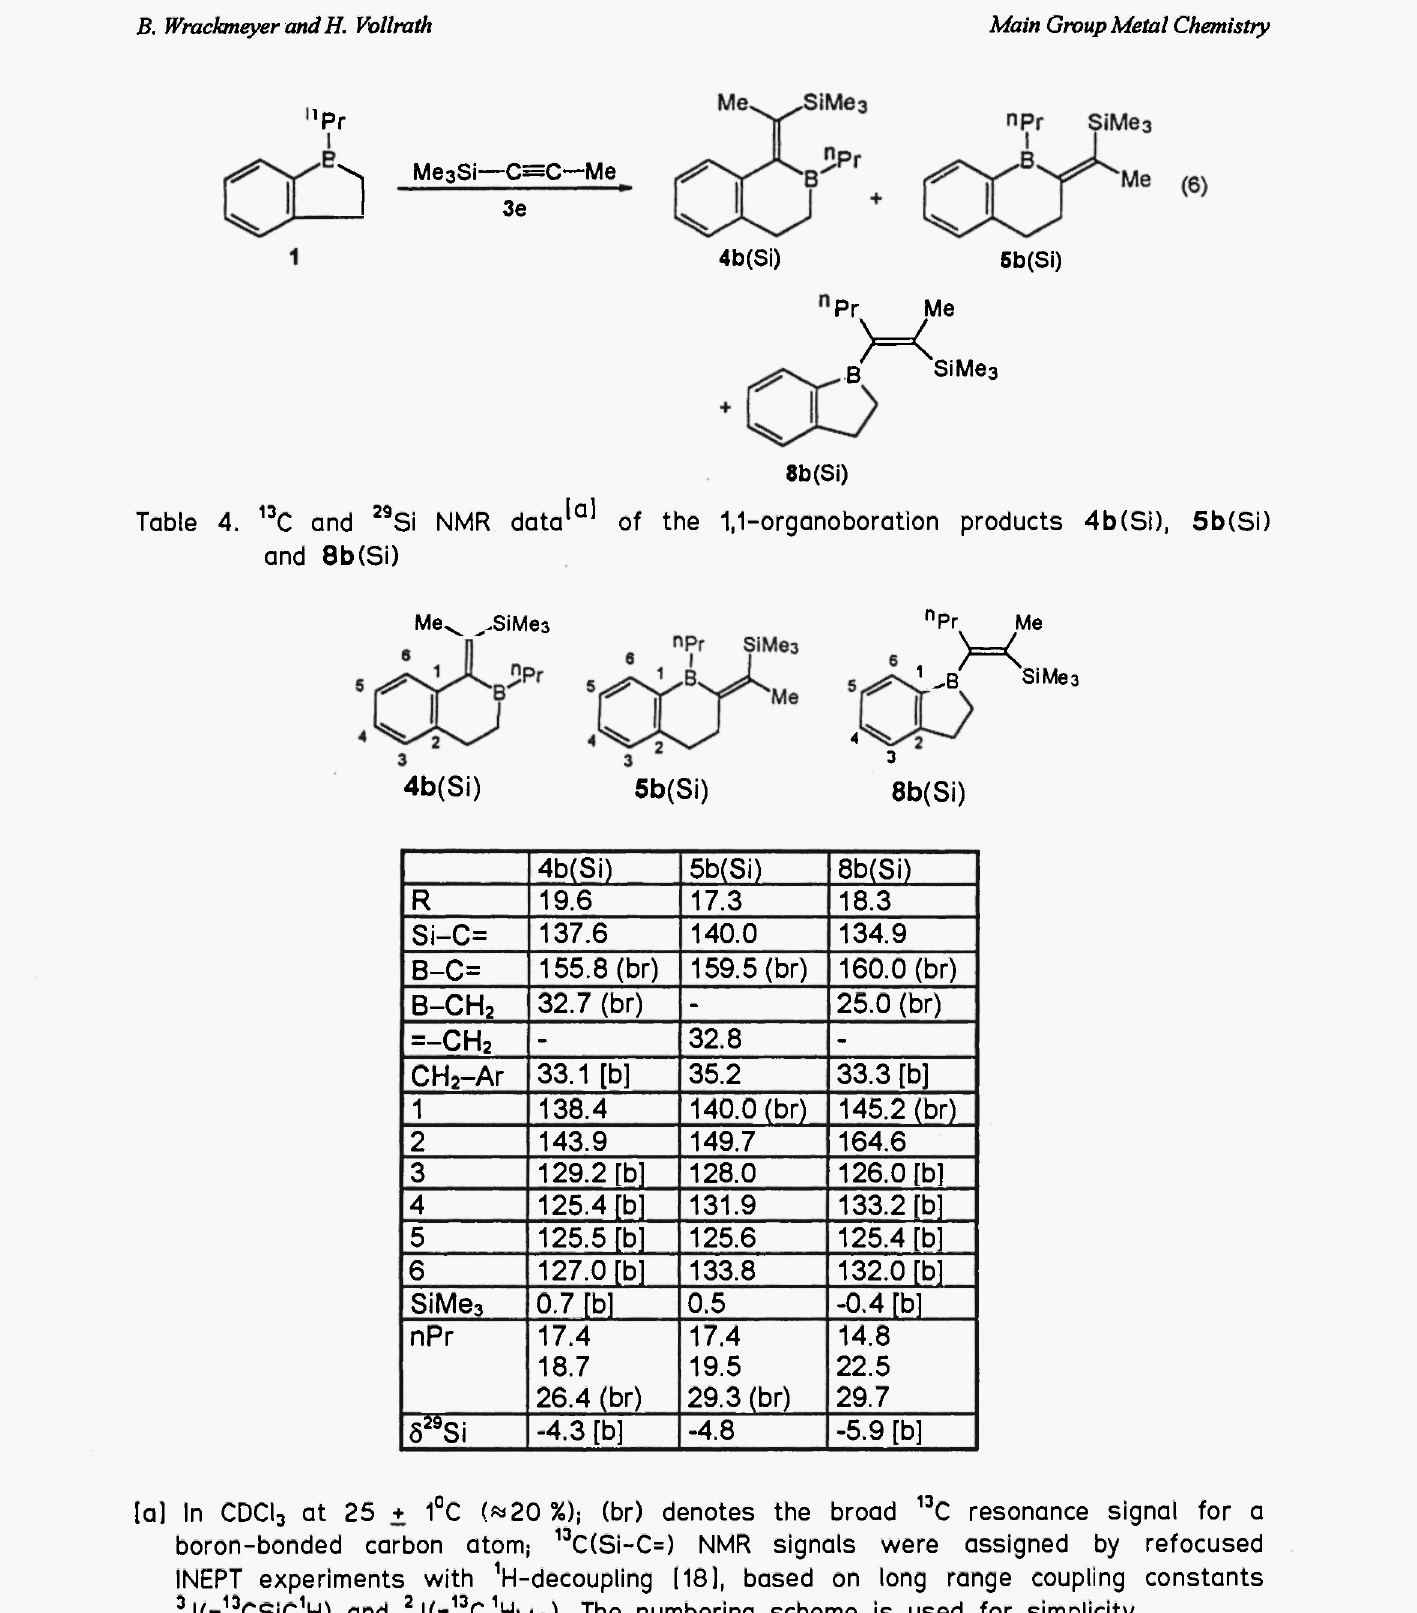
Table 4. 13 C and 29 Si NMR data Ial of the 1,1-organoboration products 4b (Si), and 8b